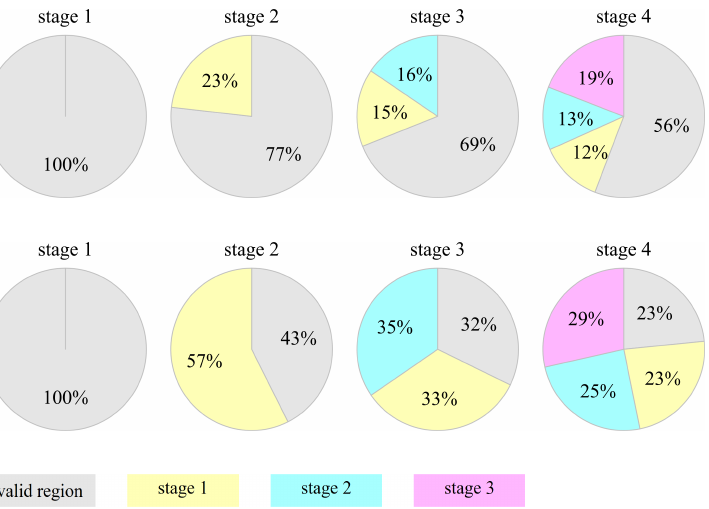
Figure 10. Region-wise contribution at each inpainting stage. The second row corresponds to the area-normalized